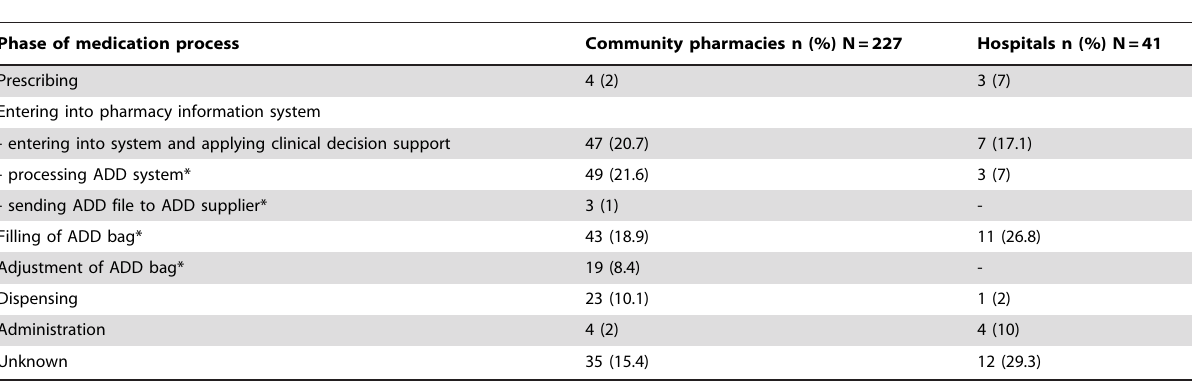
Table 1. Distribution of incidents occurring in the phases of medication process.